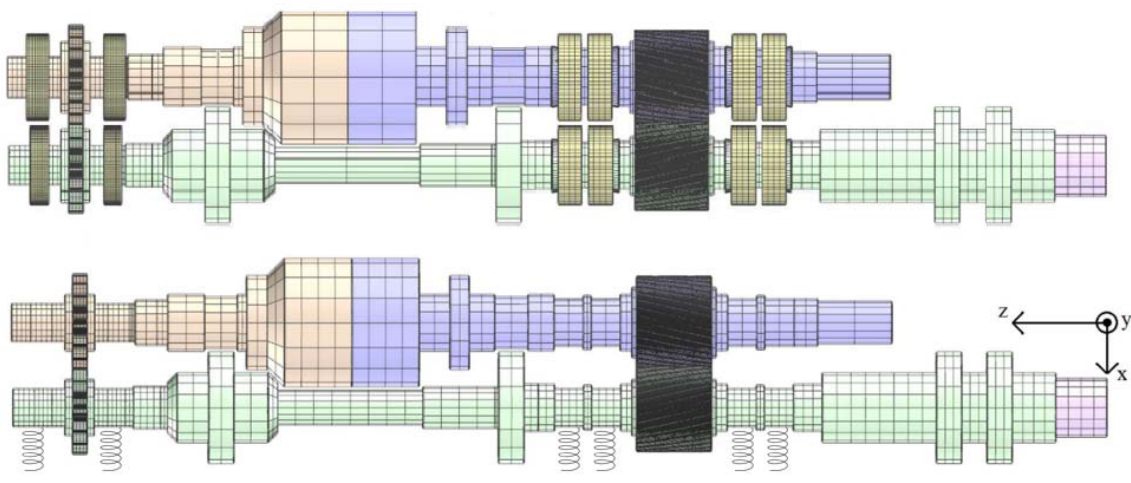
Figure 4. Simplification of the model.